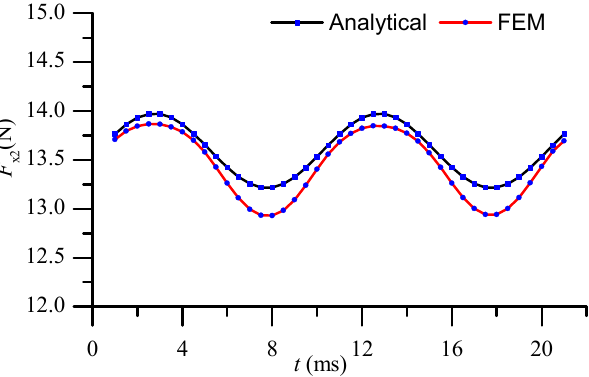
Figure 5. Comparison of eddy current braking force F x 2 between analytical and simulation.